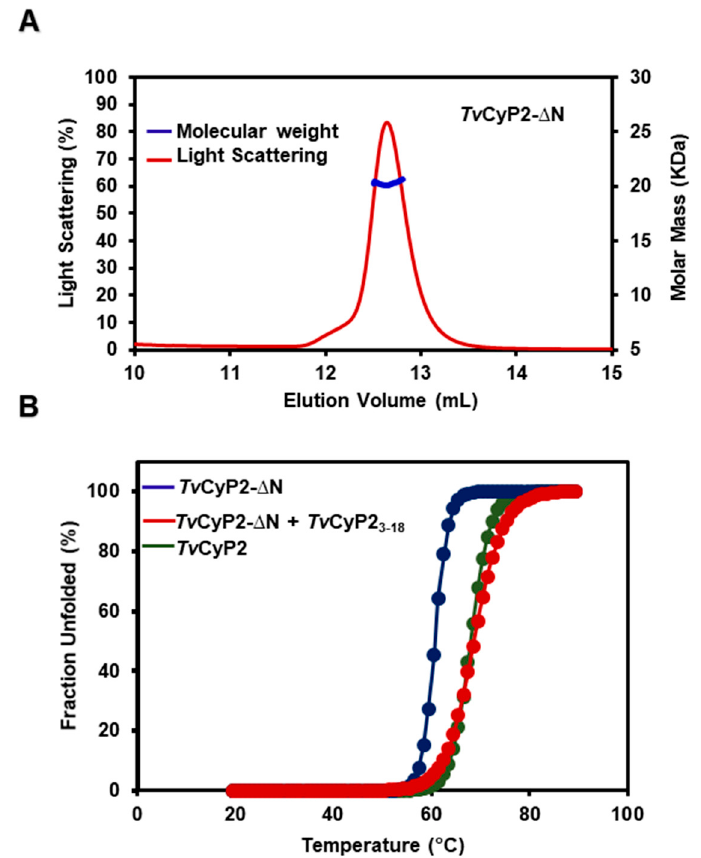
Figure 6. ( A ) SEC-MALS experiment showing that Tv CyP2- ∆ N forms a monomer in solution with molecular weight 19.5 kDa. ( B ) Thermal unfolding CD spectra for Tv CyP2 and Tv CyP2- ∆ N and Tv CyP2- ∆ N mixed with Tv CyP2 3–18 , shown in green, blue and red, respectively, from 20 to 90 °C at wavelength 222 nm. Tv CyP2 with T m 70 °C was more stable than Tv CyP2- ∆ N with T m 61 °C. For Tv CyP2- ∆ N mixed with Tv CyP2 3–18 , the melting temperature is increased, nearly the same as that of Tv CyP2.